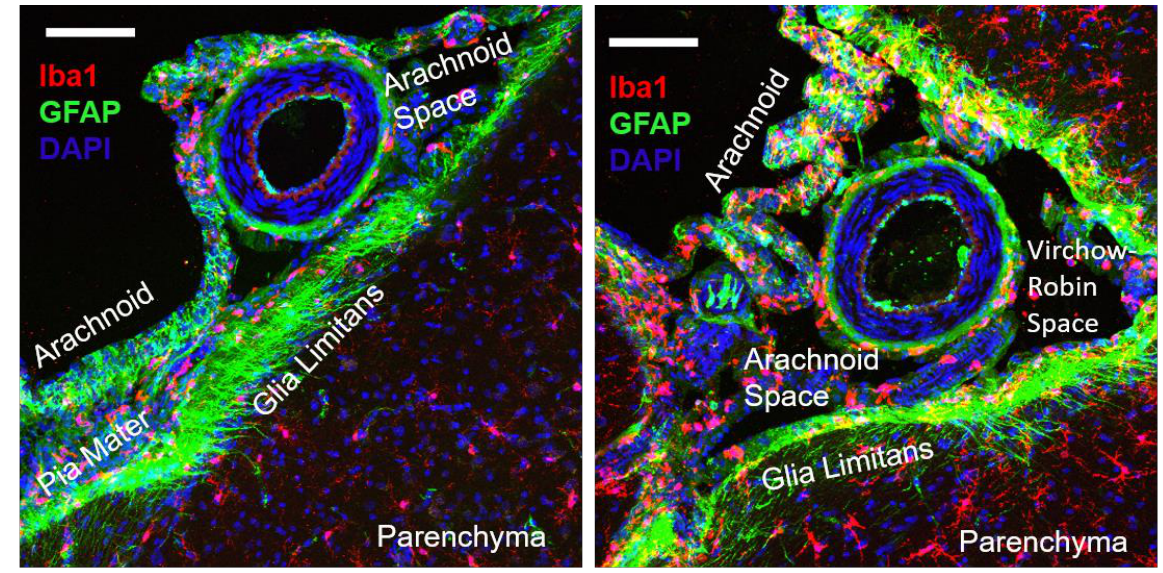
Figure 3. Representative images from a Dahl-SS/Jr prior pregnant female showing the distinct location of perivascular microglia relative to the glia limitans. Iba1+ cells could be seen along the pia mater, arachnoid, parenchyma, and surrounding the pial vessel. The glia limitans can be visualized based on GFAP expression. Red = Iba1. Green = GFAP. Blue = DAPI. Scale bar = 50 µm.